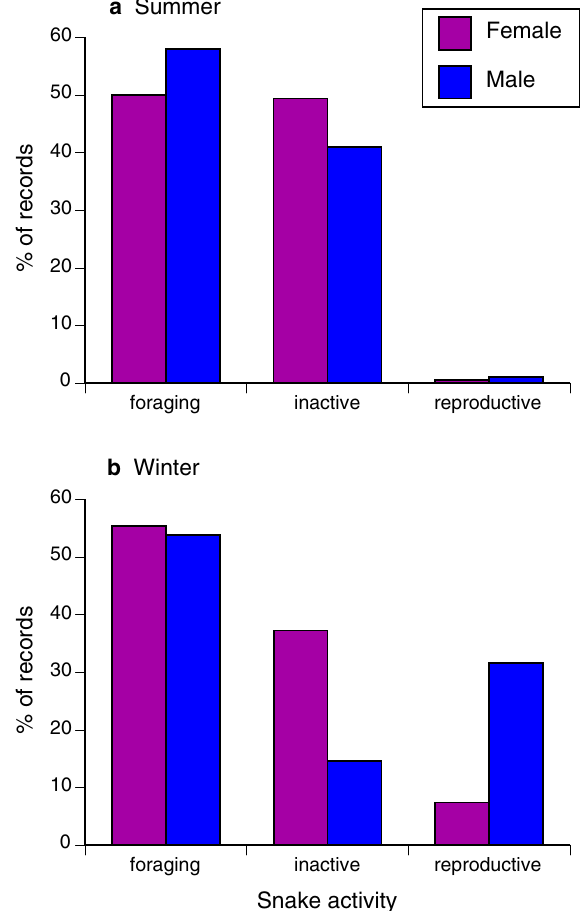
Figure 4. Interactive effects of season and snake sex on the activity of sea snakes ( Emydocephalus annulatus ) in the Baie des Citrons, New